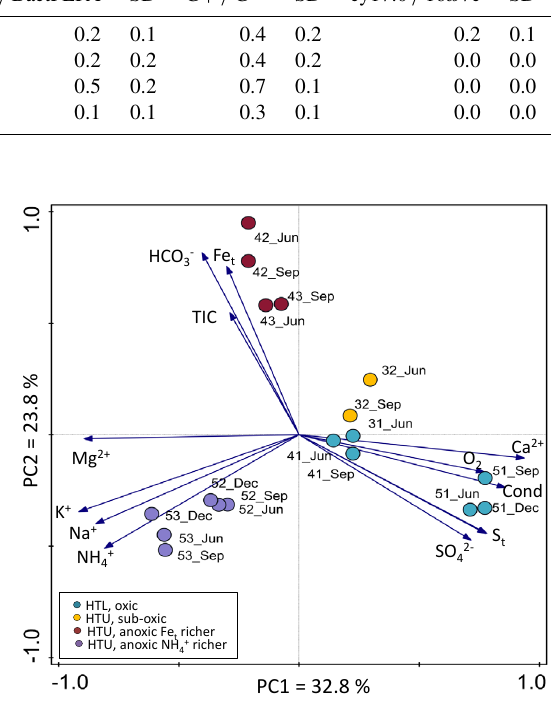
Figure 3. Principal component analysis (PCA) of the groundwa- ter physico-chemical compositions. Vectors indicate the steepest in- crease of the respective physico-chemical parameter. The different wells are represented by dots with different colours: blue for oxic groundwater, yellow for sub-oxic groundwater, dark red and violet for anoxic groundwater richer in Fe t and NH + . Note the separation 4 between the lower and upper aquifer (HTL and HTU, respectively) and the anoxic wells at location H4.2–H4.3 and H5.2–H5.3.